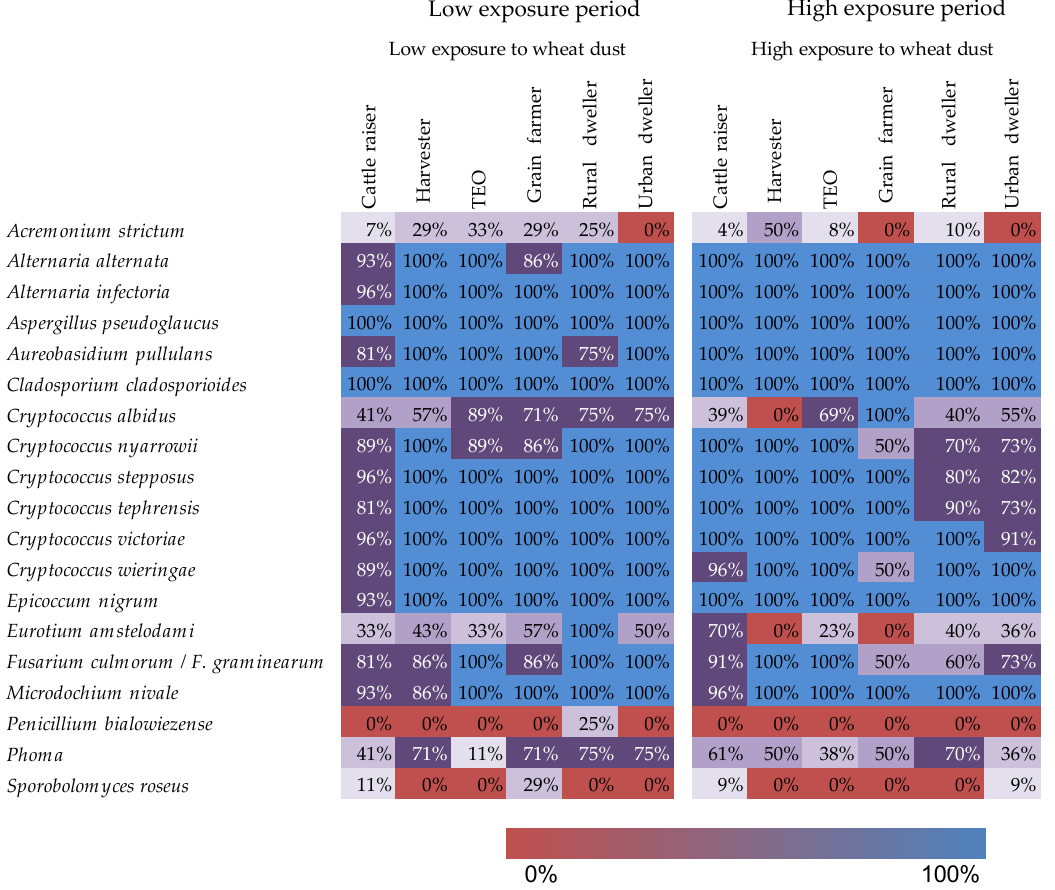
Figure 4. Heatmap illustrating the prevalence (i.e., presence–absence) of fungi of clinical importance, as a function of worker occupation and period of exposure to wheat dust. The colors and cell values indicate the proportion of samples in which the fungal species was detected.